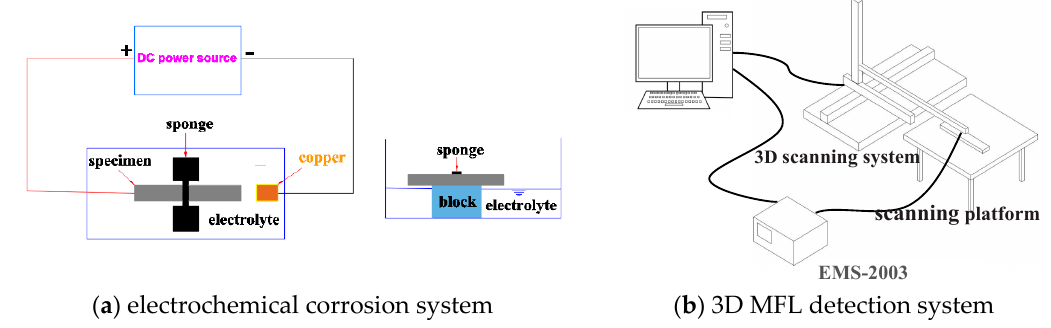
Figure 2. Schematic of the electrochemical corrosion system and the 3D Magnetic Flux Leakage (MFL) detection system.